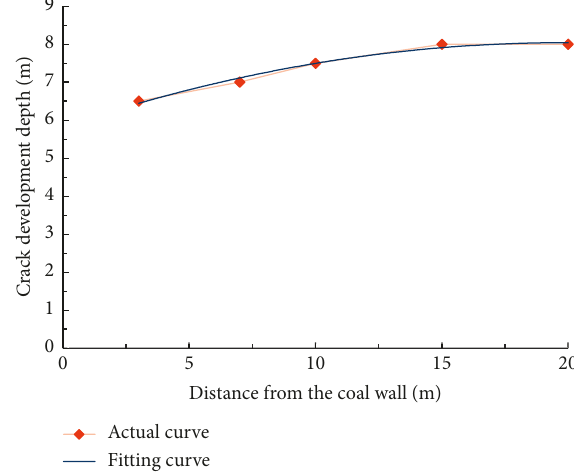
Figure 7: Fitting curve of the crack development depth and support pressure at the